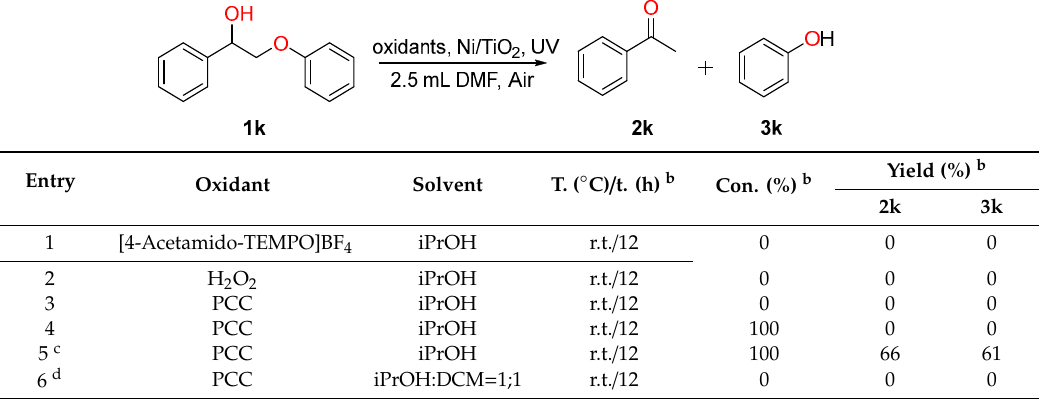
Table 4. Optimization of the oxidants for the cleavage of β - O -4 alcohols in one-pot a .